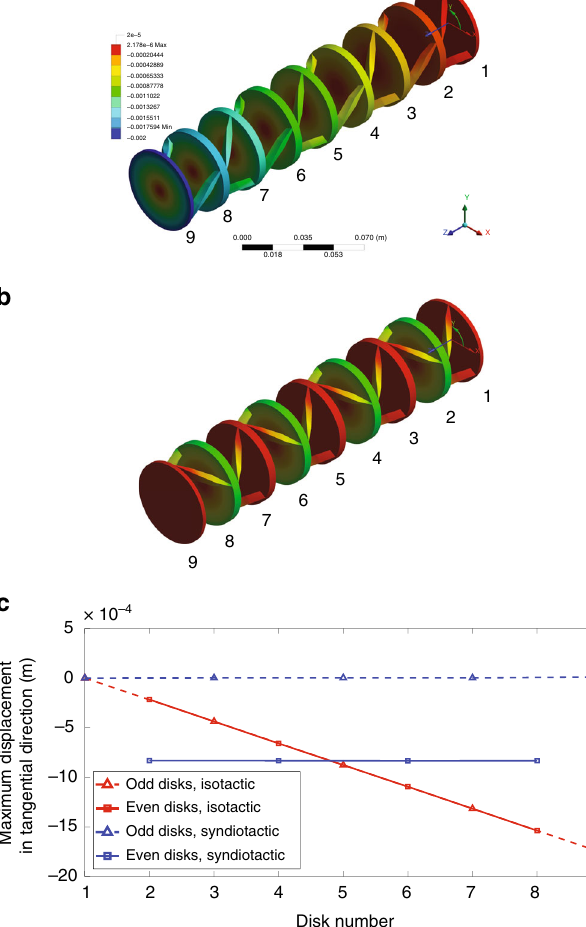
Fig. 5 In fl uence of the number of unit cells on the twist for the isotactic and syndiotactic crystals. Surface plots of the xy component of the deformation for the ( a ) isotactic and ( b ) syndiotactic crystals (4 unit cells) subjected to an axial static load. c The twist magnitude as a function of the number of disks for the isotactic (red lines) and syndiotactic (blue lines) crystals. The twist increases proportionally to the number of unit cells composing the structure in the isotactic crystal differently from the syndiotactic